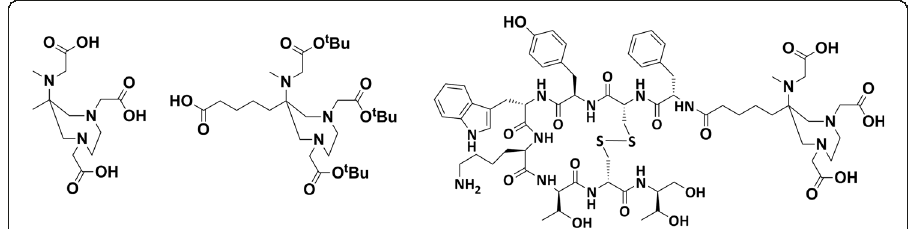
Fig. 1 DATA M , bifunctional prochelator DATA M5 -3 t Bu and DATATOC (left to